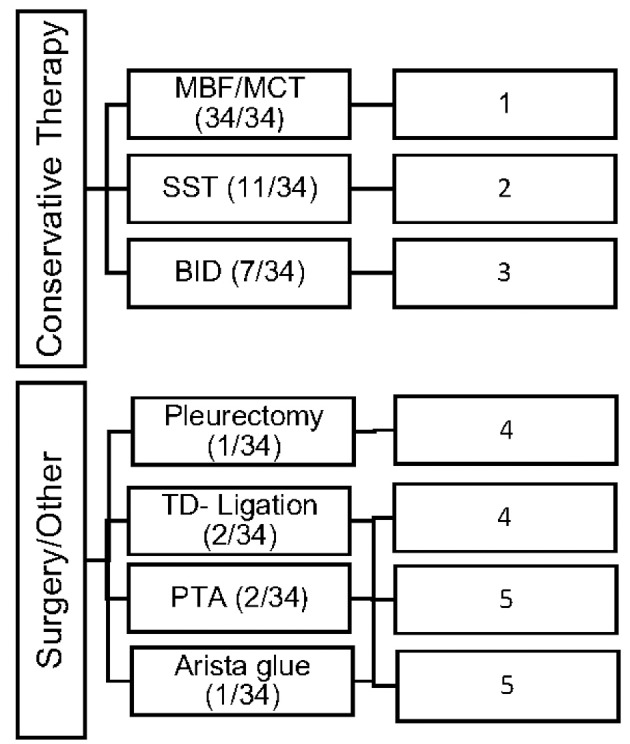
Overview of the frequency of therapeutic interventions divided into 5 categories of therapy (Type 1–5).